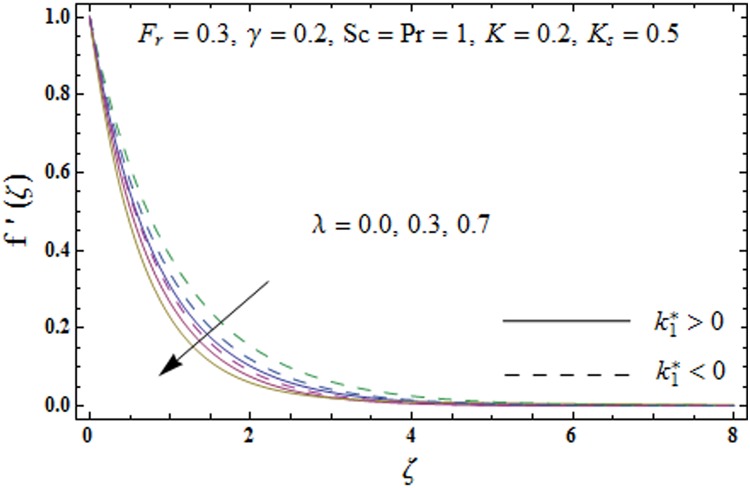
Plots of velocity field f'(ζ) for porosity parameter λ.